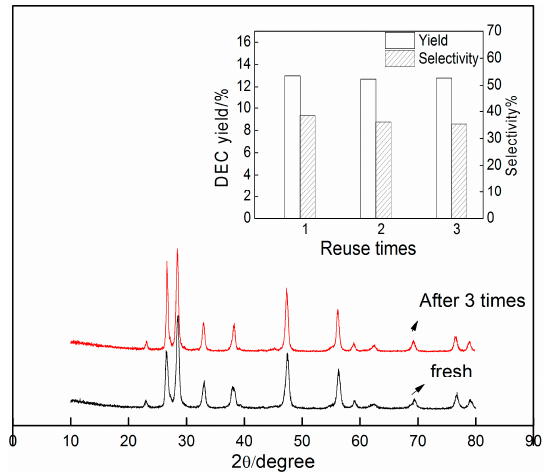
Figure 7. Recycling experiment results of the KBr ‐ KNO 3 ‐ CeO 2 (both of the volumes of ethanol and PO were 10 mL; the reaction temperature was 150 °C; the initial pressure was 5 MPa).